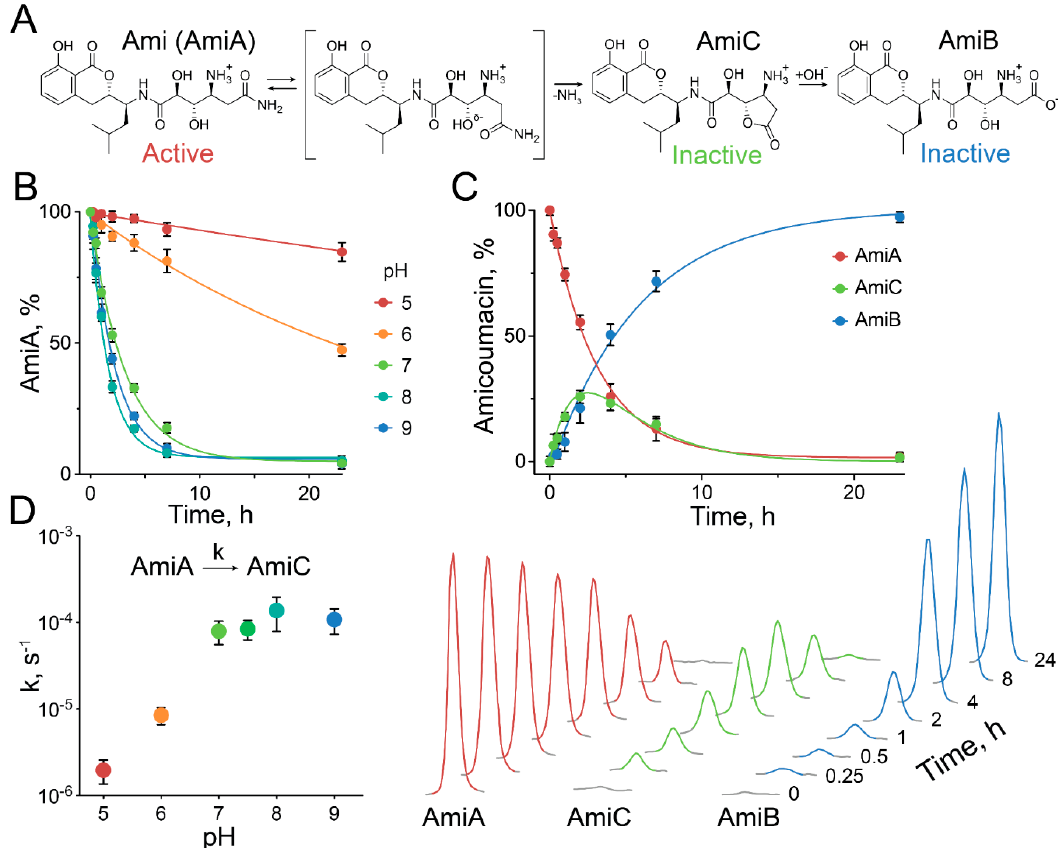
Figure 5. Ami is a particularly unstable amide, decomposing via intramolecular lactonization in physiological conditions. ( A ) General scheme, describing the sequential transformation of biologically active Ami (AmiA) into inactive amicoumacins AmiC and AmiB, respectively. ( B ) pH dependence of Ami decomposition. The residual portion of Ami over time is presented. Color indicates pH. ( C ) Representative time course of the conversion of AmiA into AmiC and AmiB, taking place at pH 7.5. The corresponding percentages of AmiA, AmiC, and AmiB in the reaction mixtures are presented. Amicoumacins were analyzed by HPLC (dots). The data were approximated by a two-step sequential reaction model (lines). The concentrations of amicoumacins were analyzed in triplicate. Data represent mean ± SD. ( D ) pH dependence of the rate-limiting step of Ami decomposition. The kinetic constants of the self-conversion of AmiA into AmiC are presented for pH 5–9. Data represent mean ± SD.